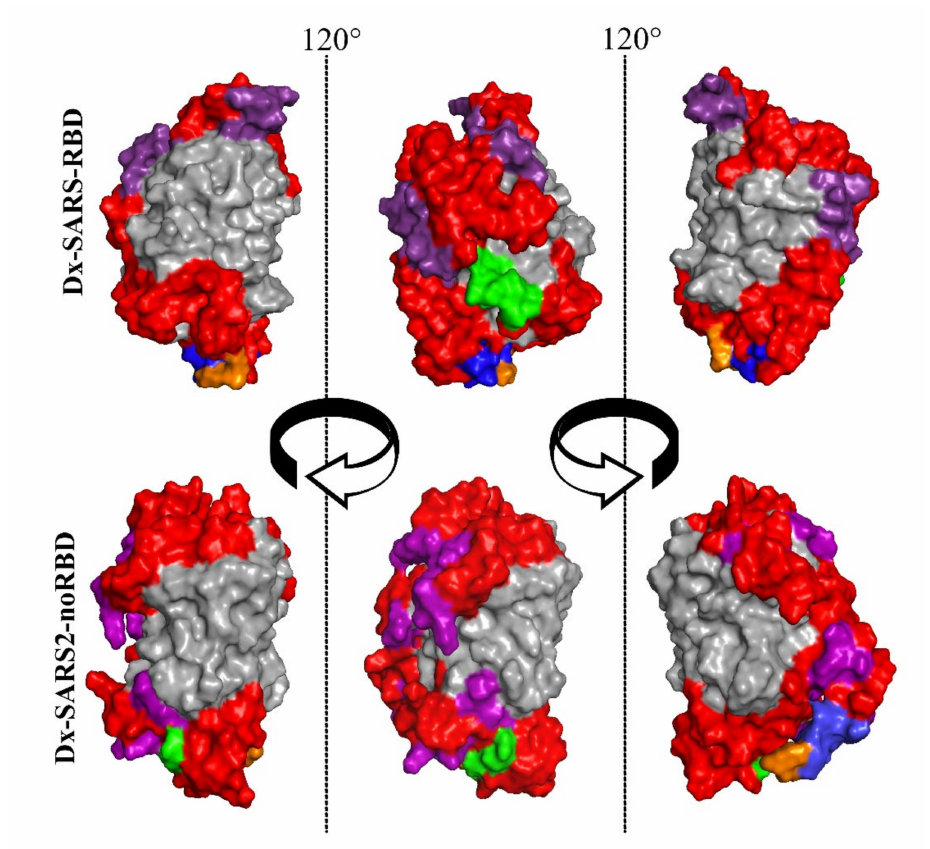
Figure 1. Space-filling models of Dx-SARS-RBD and Dx-SARS2-noRBD multiepitope proteins. The amino acid sequences of Dx-SARS-RBD ( top row) and Dx-SARS2-noRBD ( bottom row) were submitted to I-Tasser for computer modeling without a template. The resulting structures were converted into space-filling models using PyMOL and color-coded gray for the receptacle, red for epitopes, purple for spacers, green for the amino terminus, blue for a 6xHis tag, and orange for the carboxy